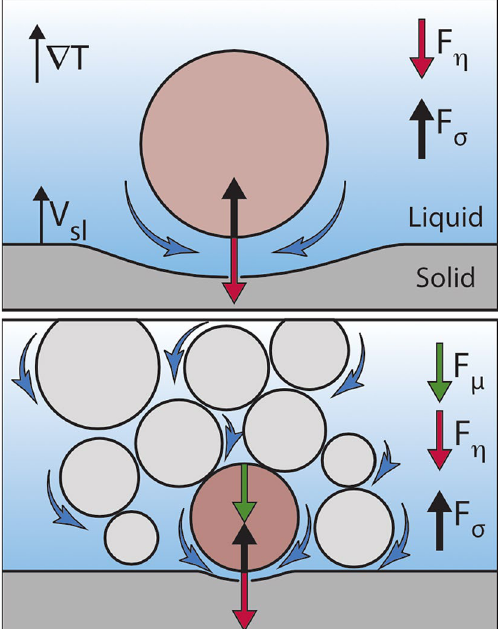
Figure 1. Force equilibrium to predict engulfment or rejection of objects in the presence of multiple particles. The particle–particle interactions during solidification can result in the formation of a compact layer, which acts as a porous medium. The subsequent resistance offered to the flow of fluid (blue arrows) towards the growing solid results in an additional frictional force F µ , which favors object engulfment. The modified force equilibrium is hence given as F η + F µ = F σ , where F η is an attractive viscous drag force and F σ is a repulsive interfacial force. ∇ T = G is the applied temperature gradient and V sl is the imposed growth rate. © (2020) S. Tyagi et al. (10.6084/m9.figshare.13176221) CC BY 4.0 license https ://creat iveco mmons .org/licen